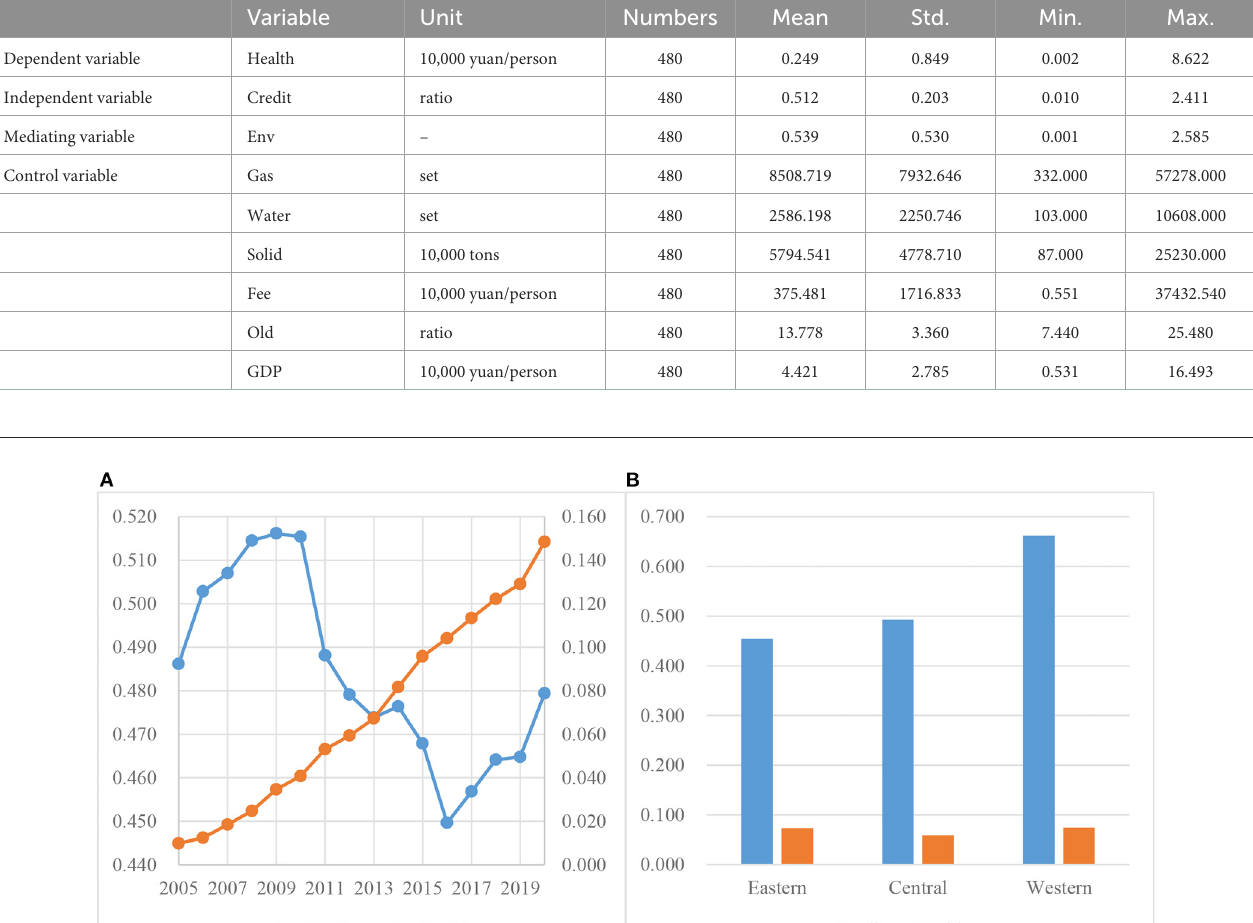
TABLE 1 Variable descriptive statistics.